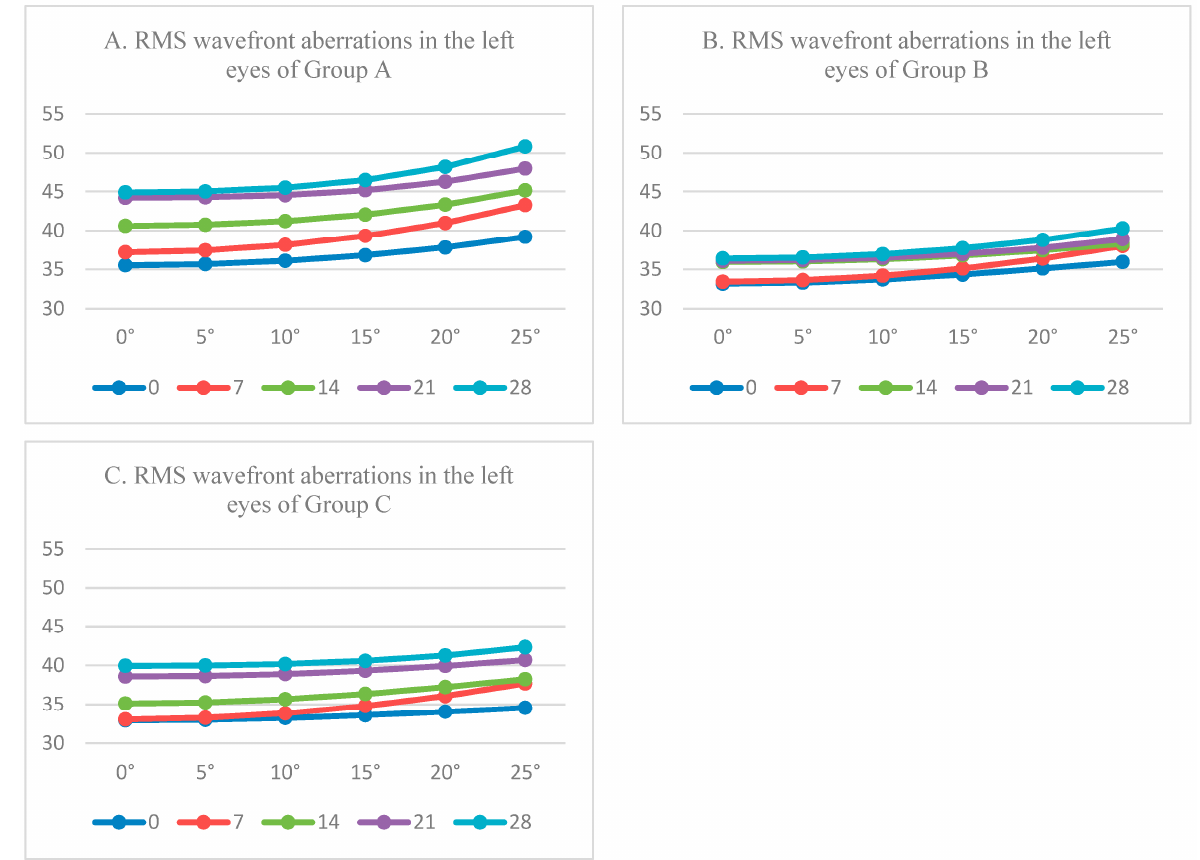
Figure 7. The RMS wavefront aberrations of mice.